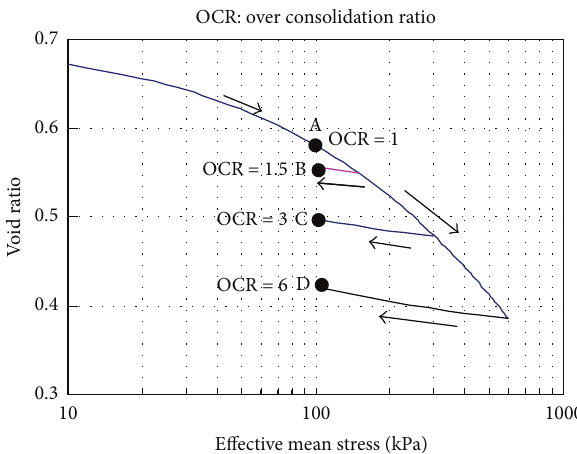
Figure 2: Mechanical consolidation simulation results before non- isothermal consolidation.